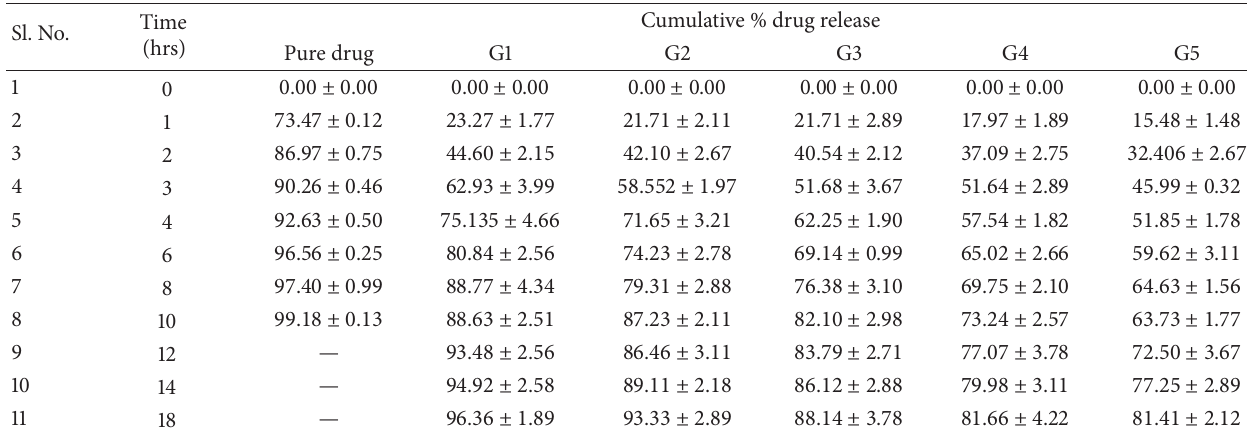
Table 4: Effect of polymer ratio on drug release in 0.1N HCl.